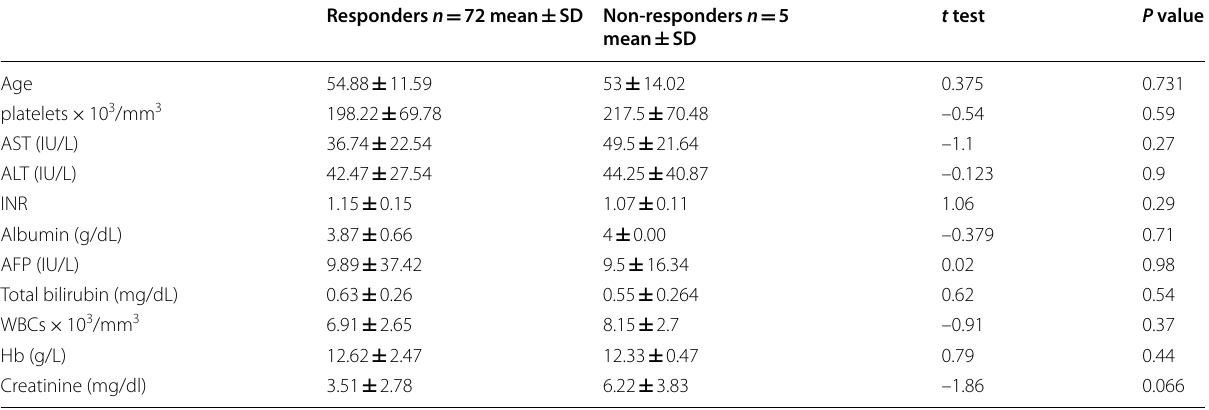
Table 3 Relation between response to treatment and the quantitative